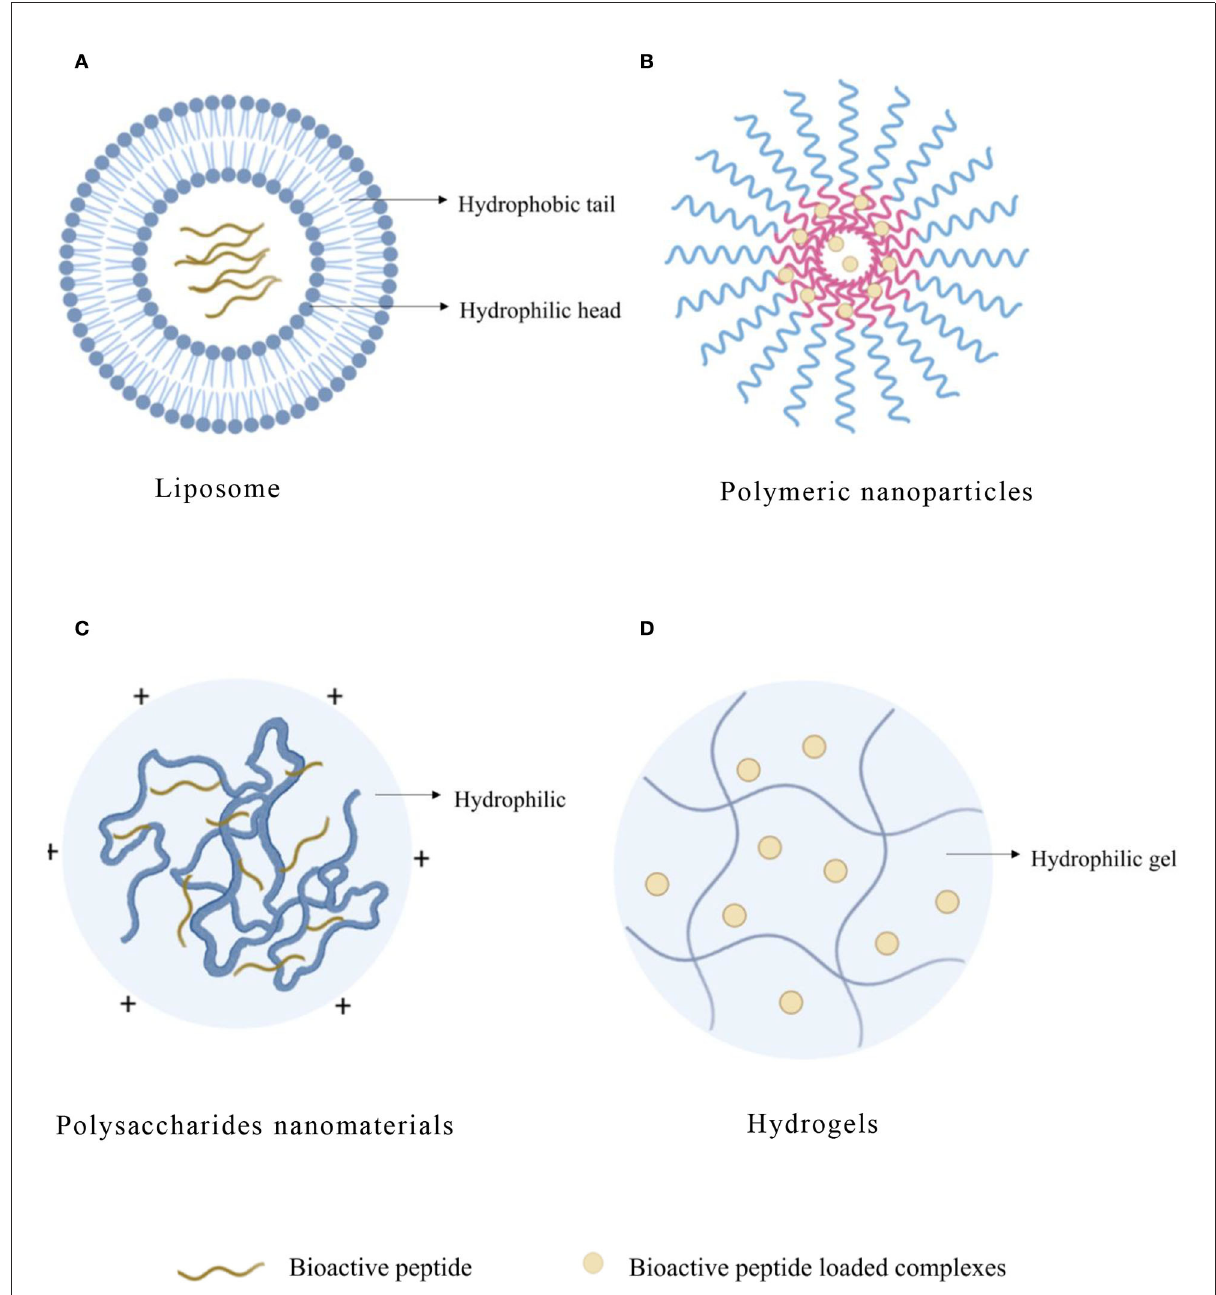
as drug delivery carriers, including ease of